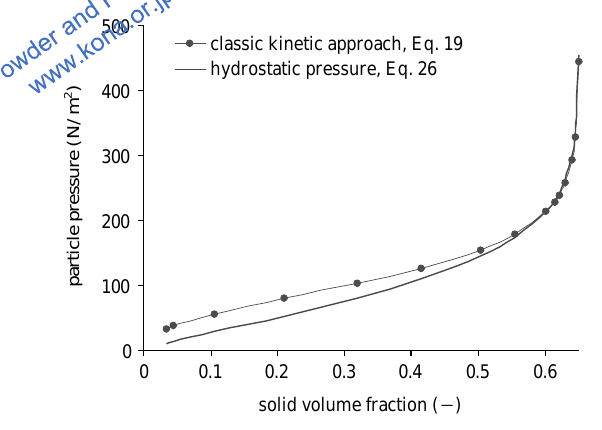
Comparison between the hydrostatic pressure and classic kinetic model predictions.